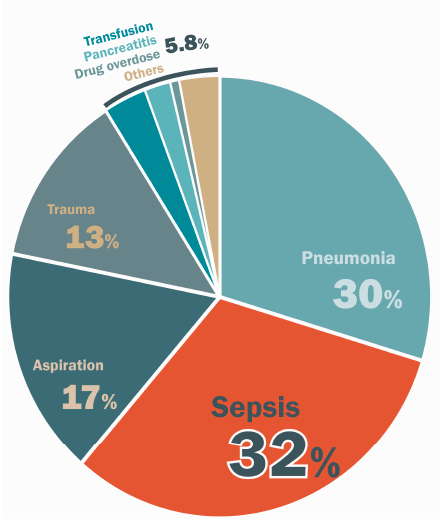
Figure 1. The etiology of acute respiratory distress syndrome (ARDS) (adapted from Bersten et al. [13]).